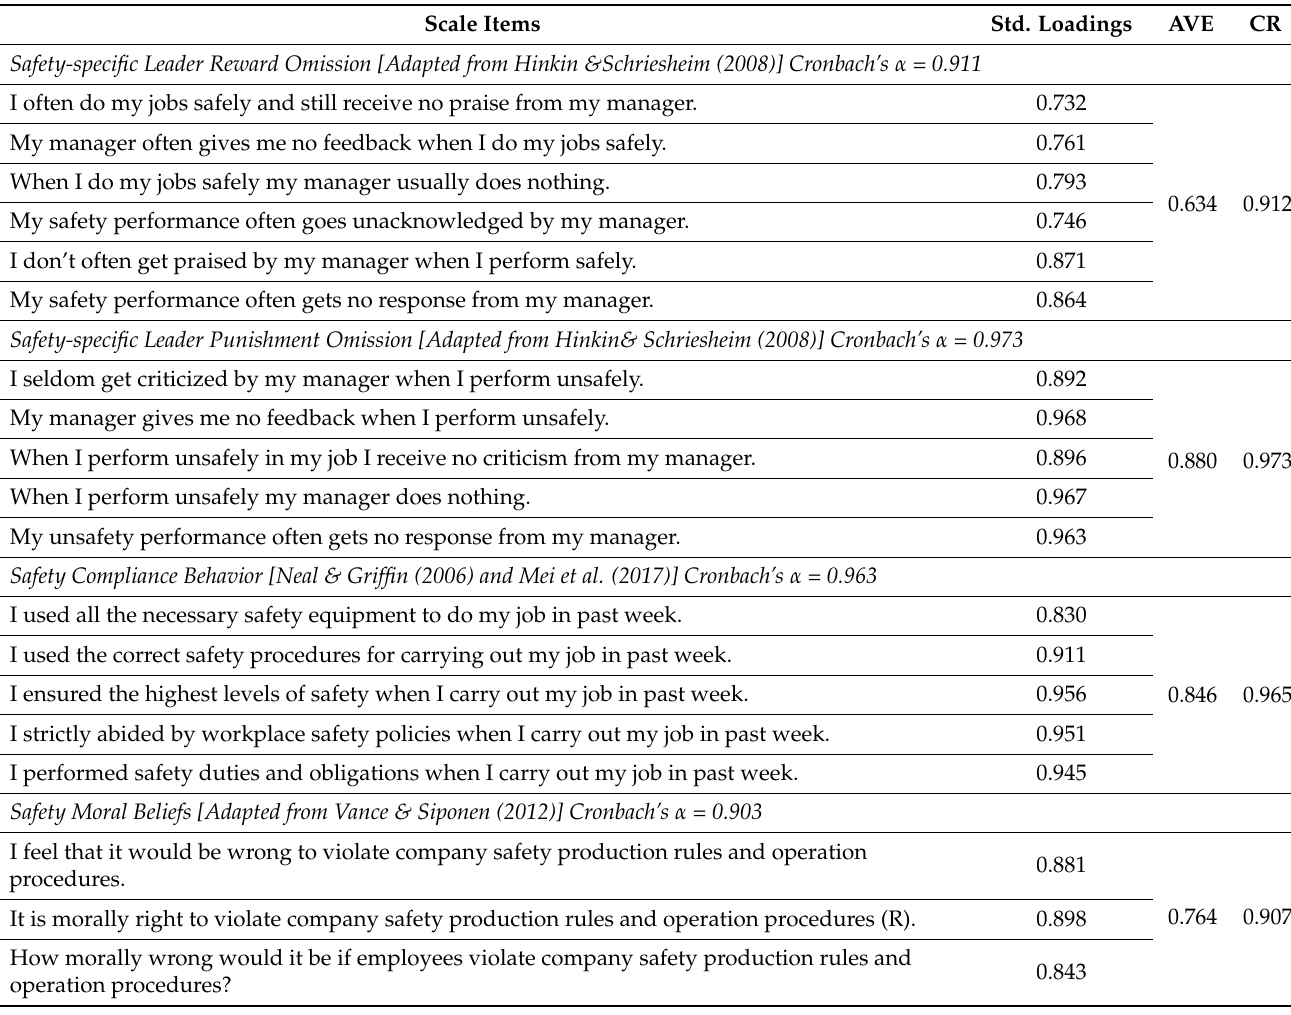
Table 1. Scale items and results of